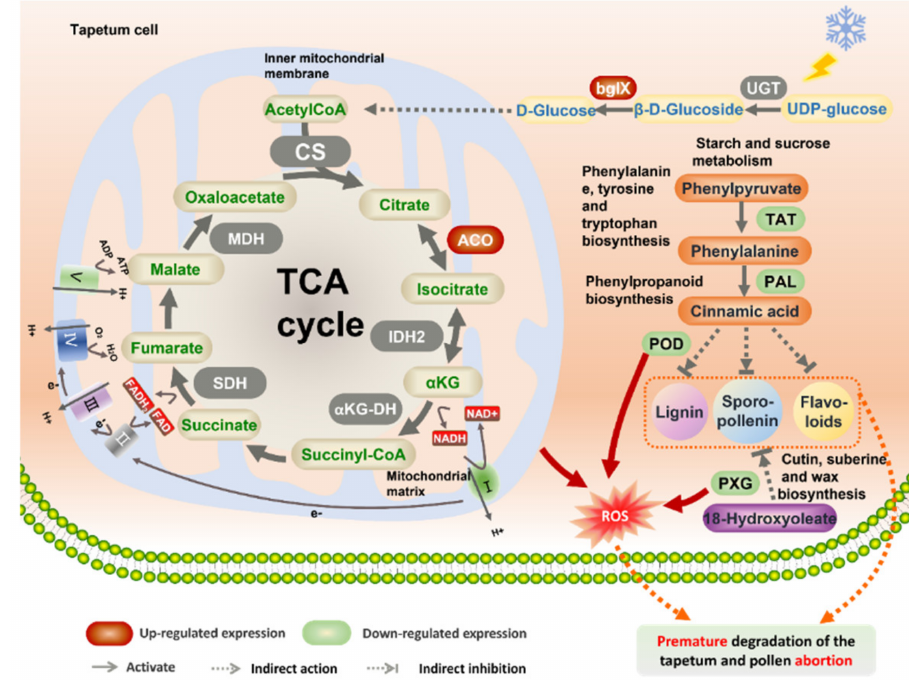
Figure 8. Possible transcriptome-mediated male sterility network in FA99. UGT, UDP-glucose gluco- syltransferase; bglX, β -glucosidase; CS, citrate synthase; MDH, malate dehydrogenase, SDH, succinate dehydrogenase; α KG-DH, 2-oxoglutarate dehydrogenase E1 component; IDH 2 , isocitrate dehydro- genase; ACO, aconitate hydratase; FAD, flavin adenine dinucleotide; FADH 2 , flavine adenine din- ucleotide, reduced; NAD, nicotinamide adenine dinucleotide; NADH, nicotinamide adenine din- ucleotide; TAT, tyrosine aminotransferase; PAL, phenylalanine ammonia-lyase; POD, peroxidase; PXG, peroxygenase; ROS, reactive oxygen species; I, NADH dehydrogenase; II, succinate dehydroge- nase; III, cytochrome bc1 complex; IV, cytochrome c oxidase; V, ATP